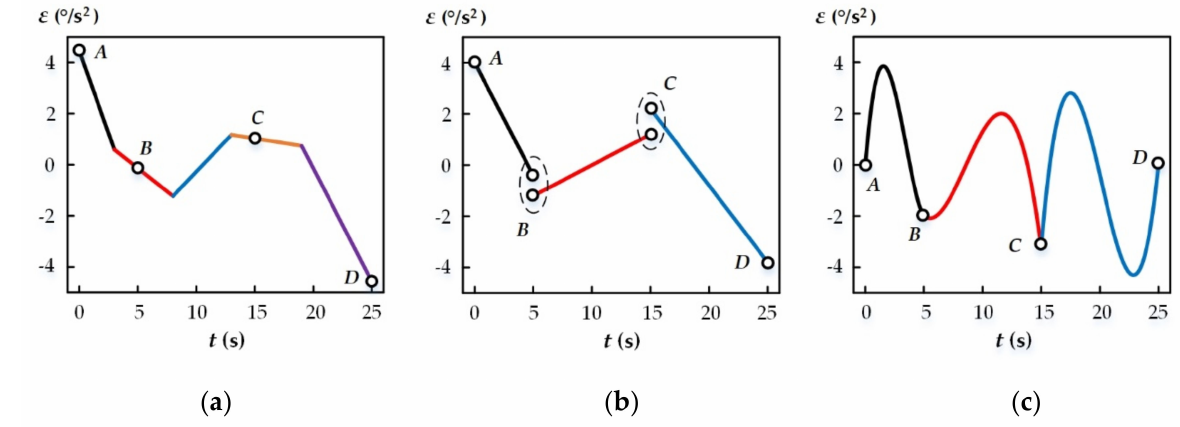
Figure 15. Angular acceleration comparison: ( a ) Proposed methodology planning; ( b ) Cubic polynomial planning; ( c ) Quintic polynomial